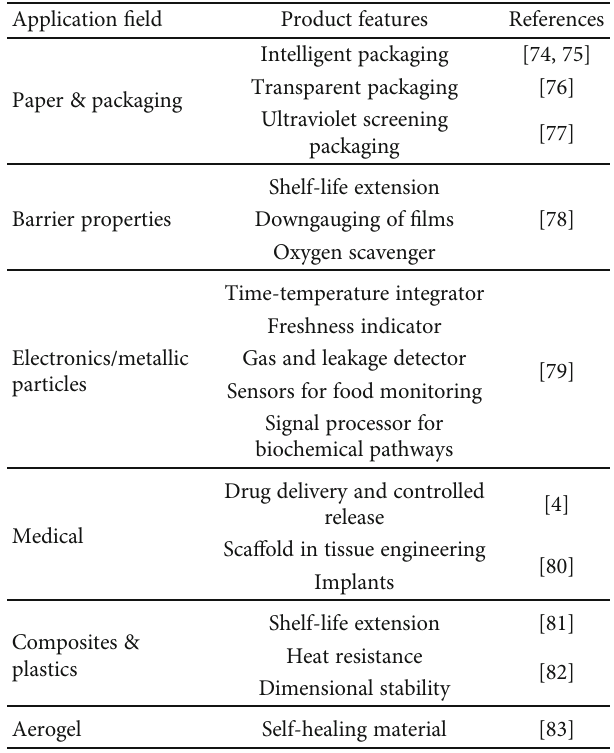
Table 5: Cellulose nanocomposite application in di ff erent